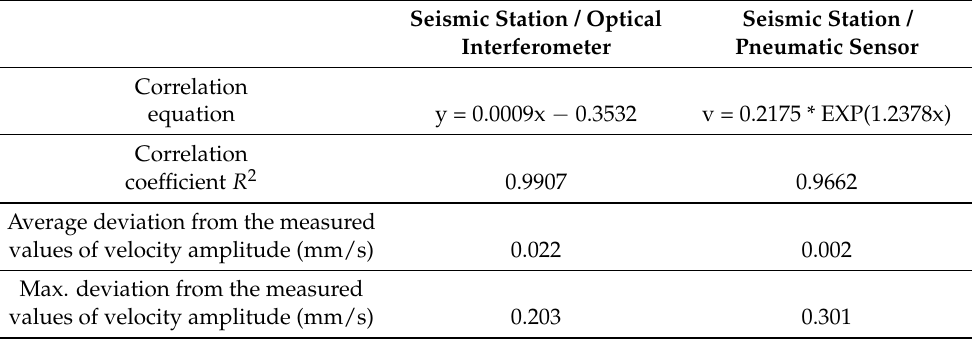
Table 3. Summary results of data mathematical processing of the comparative measurement of the optical interferometer system and the pneumatic